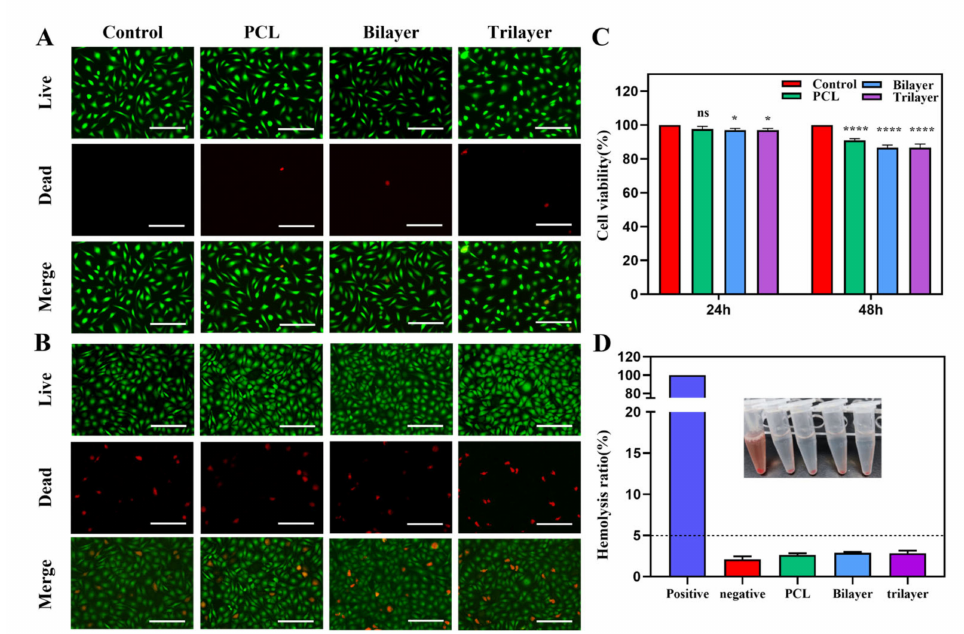
Figure 4. ( A ) The Live/Dead staining of control, PCL, bilayer, and trilayer on 24 h. ( B ) The Live/Dead staining of control, PCL, bilayer, and trilayer on 48 h. ( C ) Cell viability of control, PCL, bilayer, and trilayer on 24 h and 48 h ( n = 3, ns = not significance. * p < 0.05, **** p < 0.0001 compared with control group, mean ± SD). ( D ) Hemolysis ratio of control, negative, PCL, bilayer, and trilayer ( n = 3). Scale bars are 100 µ m in ( A , B